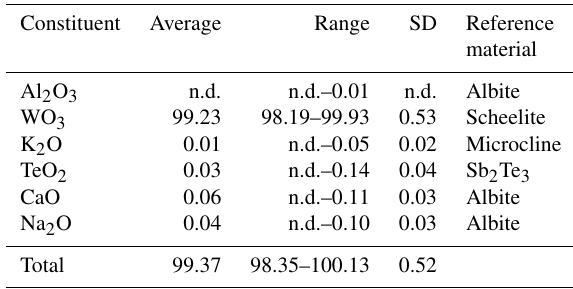
Figure 6. X-ray powder diffraction pattern of liguowuite (Cu K α